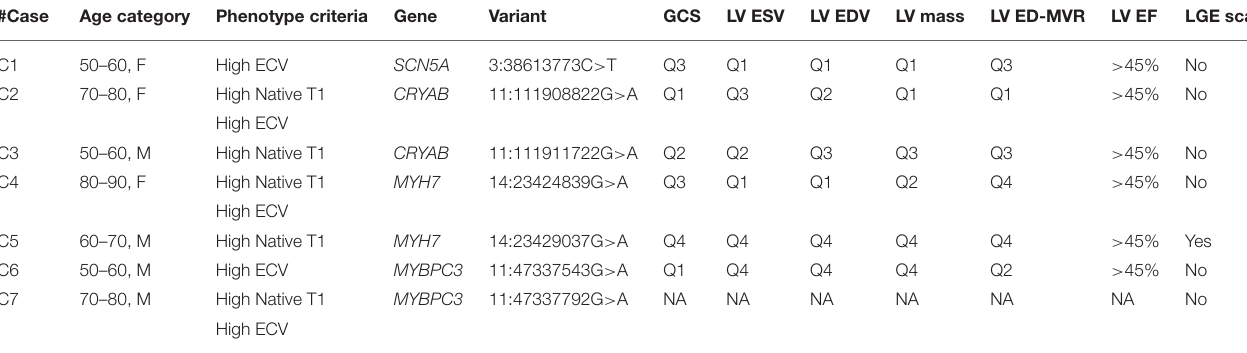
TABLE 3 | Individual-based description of global circumferential strain and LV anatomical features in cases with P/LP/VUS + variants. #Case